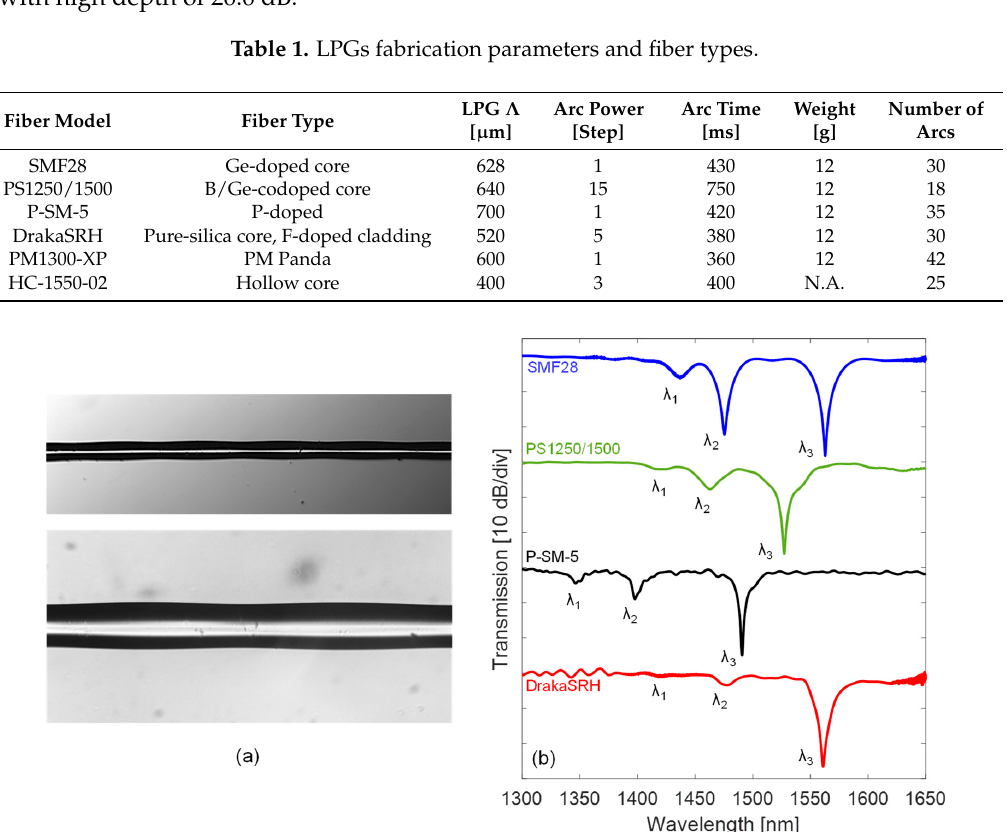
Figure 3. ( a ) Pictures of optical fiber with tapering effect due to arc-induced LPG; ( b ) Transmission spectra of LPGs in different single mode silica fibers.